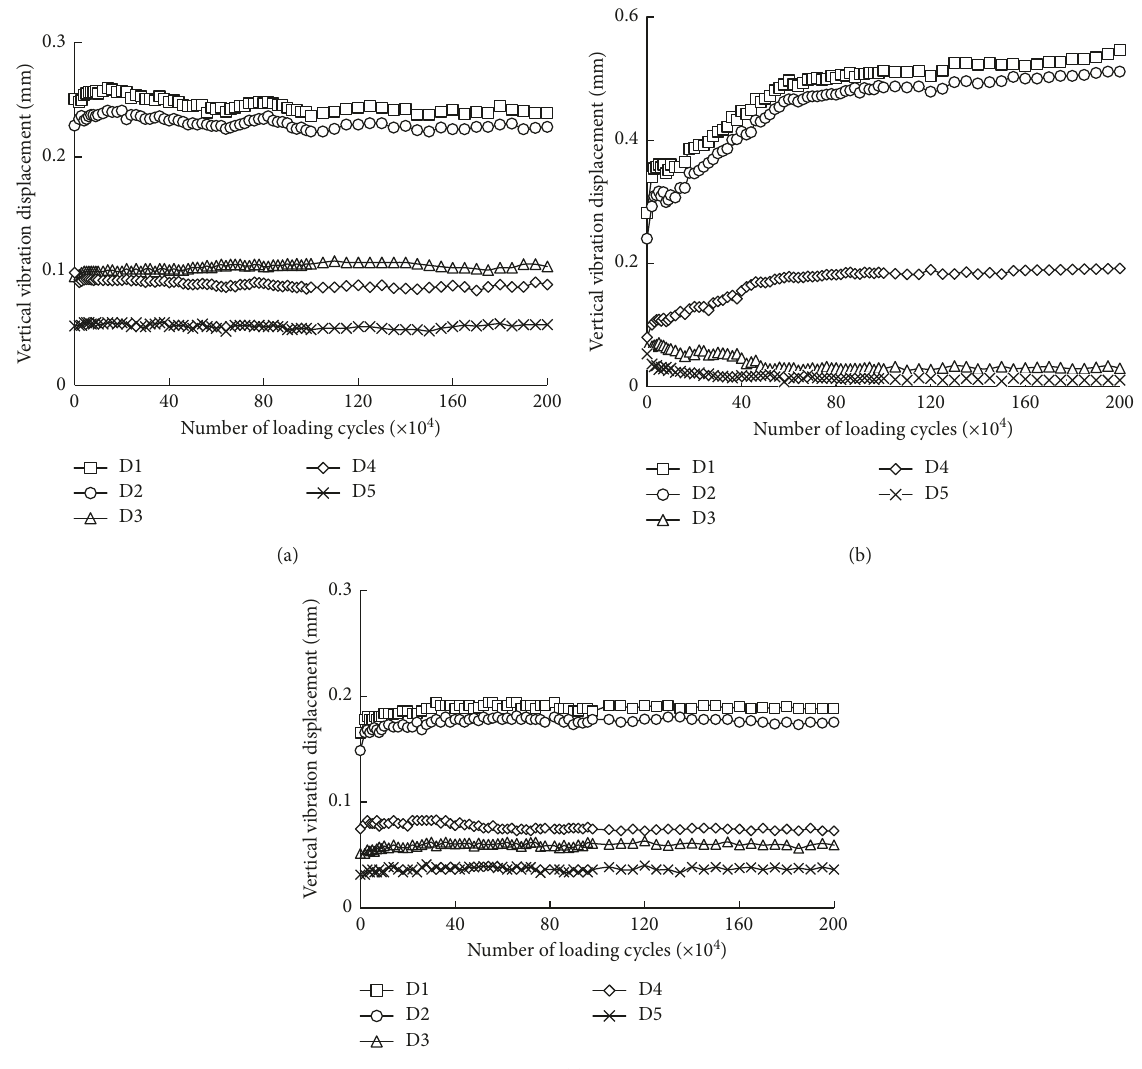
Figure 12: The variation of the vertical vibration displacement of the model with the number of loading cycles. (a) The upper layer of the subgrade bed in normal condition (stage 1). (b) The upper layer of the subgrade bed in saturation (stage 2). (c) The model after mud pumping reinforcement (stage 3).